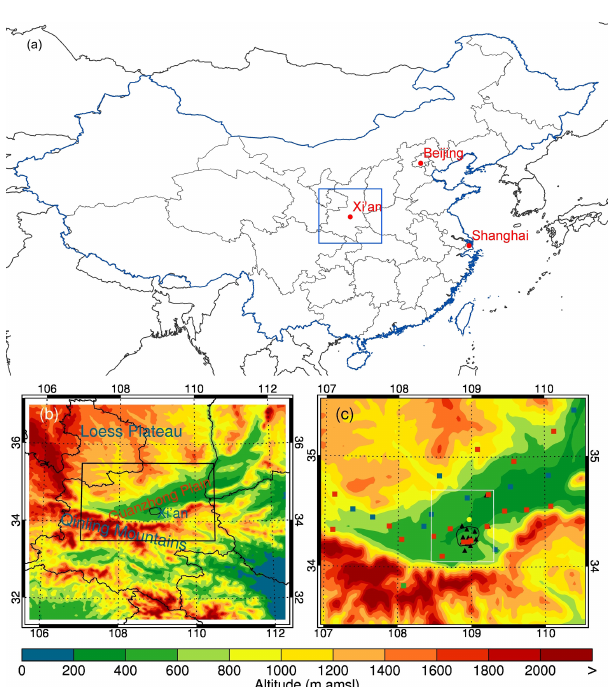
Figure 1. Map showing (a) the location of Xi’an in China, (b) WRF-CHEM model simulation domain with topography and (c) geographic distributions of 13 ambient air quality monitoring stations (black triangles) and 29 enhanced sites with filter measure- ments (squares). The filled red, blue, and green squares represent the urban, rural, and background sites, respectively. The area sur- rounded by the white line in panel (c) is defined as Xi’an and sur- rounding areas. The black circle in panels (b) and (c) shows the ring expressway of Xi’an. The yellow spot is the location of the Jinghe meteorological